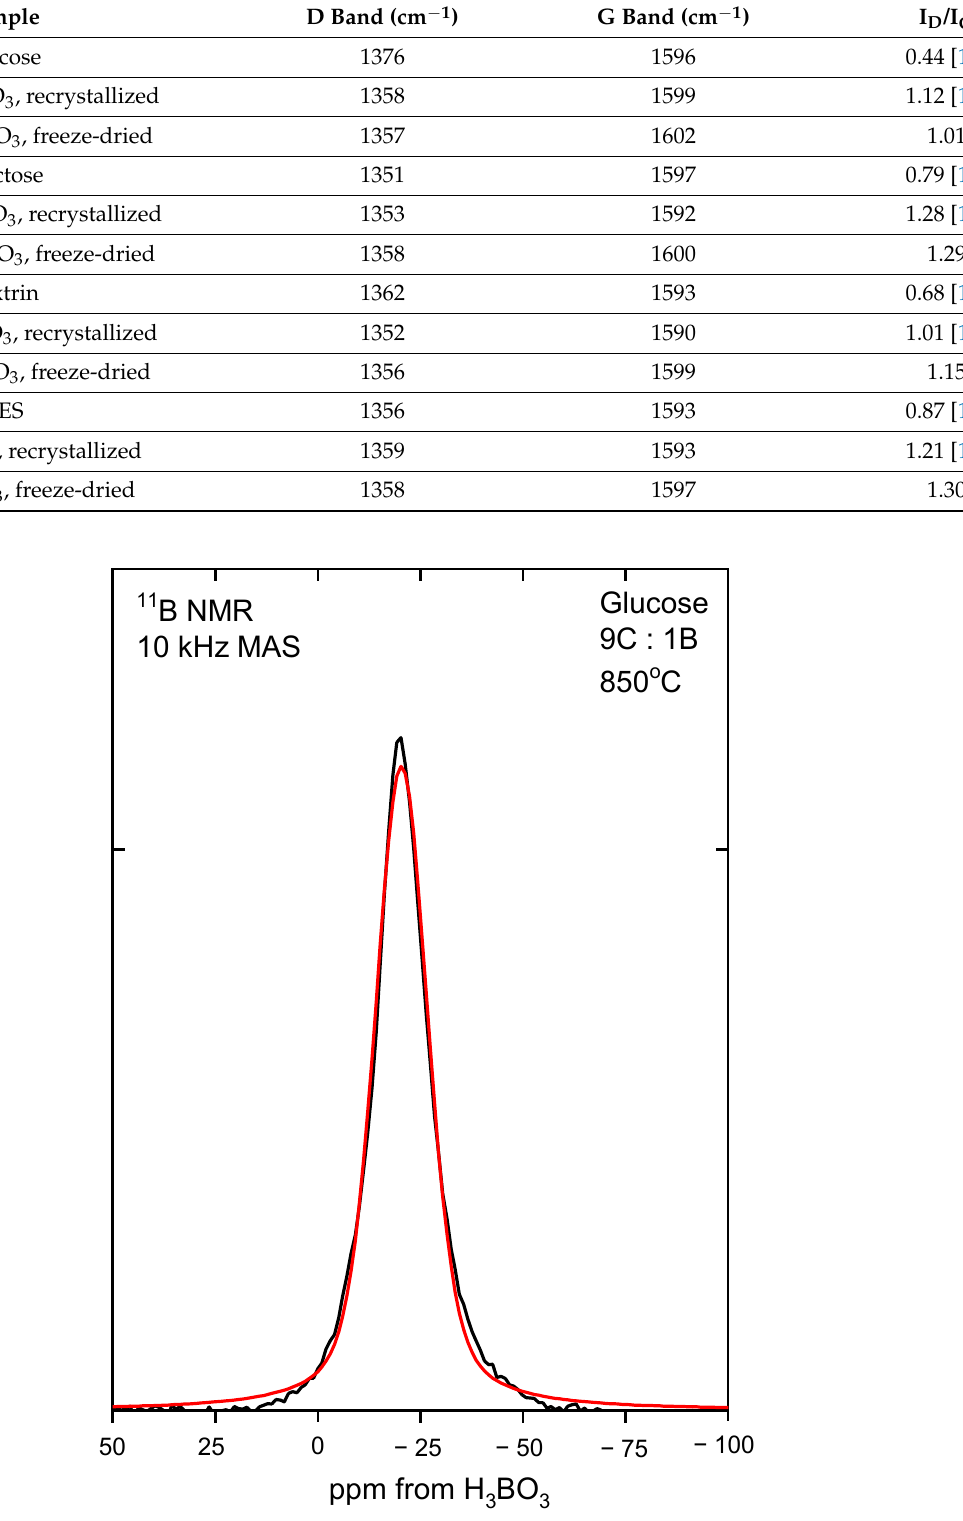
Figure 4. An example of a deconvoluted 11 B MAS NMR spectrum of fructose mixed with boric acid in a molar ratio of 9 C:1 B and then recrystallized.